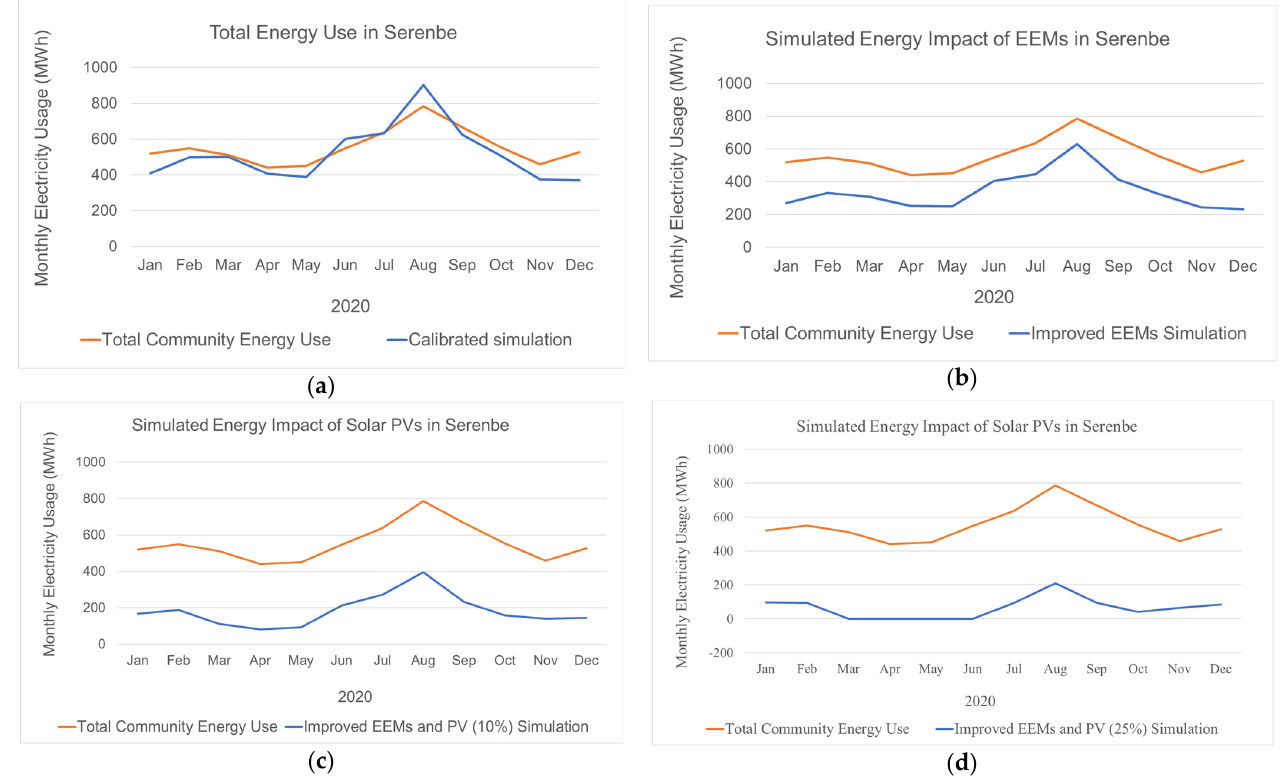
Figure 12. Systematic energy analysis for the Serenbe community to become NZC. ( a ) Calibrated base case vs. measured baseline (utility and PV generation). ( b ) Improved EEM simulation vs. measured baseline. ( c ) Improved EEMs and PV (10%) simulation vs. measured baseline. ( d ) Improved EEMs and PV (25%) simulation vs. measured baseline. Note: 1Megawatt hour (MWh) = 1000 kilowatt-hours (kWh).